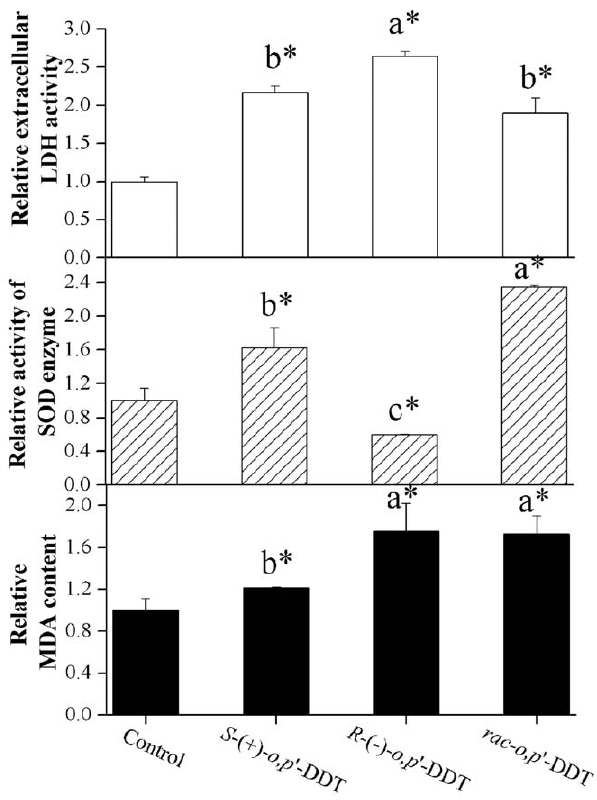
Figure 1. Oxidative stress induced by racemate and enantio- mers of o,p’ -DDT. Effect of the racemate of o,p’ -DDT and individual stereoisomers on extracellular lactate dehydrogenase (LDH) release, intracellular superoxide dismutase (SOD) and malondialdehyde (MDA) production at concentration of 3.5 6 10 2 5 mol/L. Data are presented as the relative value of control. PC12 cells were exposed to different compounds for 24 h. The asterisk above each bar indicates a significant difference compared to a negative control ( p , 0.05, n=3). Different letters above adjacent bars indicate a significant difference ( p , 0.05) between the two enantiomers, whereas the same letter indicates no significant difference.